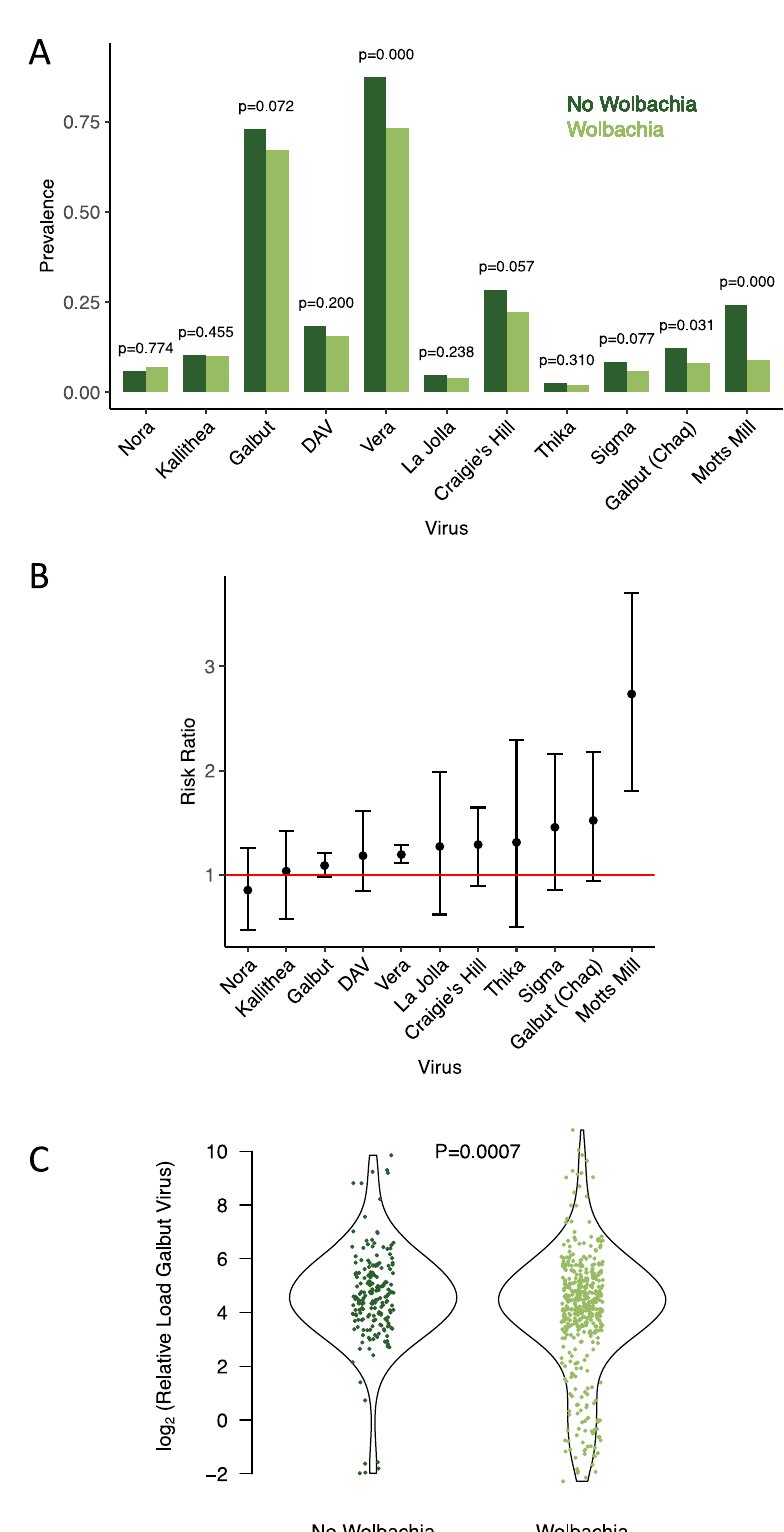
Fig. 2 Viral prevalence and load in Wolbachia -free and Wolbachia -infected fl ies. A The prevalence of viruses in male D. melanogaster . The bars are the posterior means of the random effect estimates of a glm. The p values are posterior probabilities that the prevalence differs in Wolbachia -free and Wolbachia -infected fl ies, estimated from the glm. B The risk of viral infection in Wolbachia- free fl ies relative to Wolbachia -infected fl ies. Values above 1 indicate that Wolbachia- free fl ies are more likely to be infected. The points are posterior means and the error bars are 95% credible intervals estimated from a glm. C Viral load of Galbut virus in fl ies with and without Wolbachia . Viral load is measured by quantitative PCR relative to the Rpl32 mRNA. The P - value is the result of a one-way